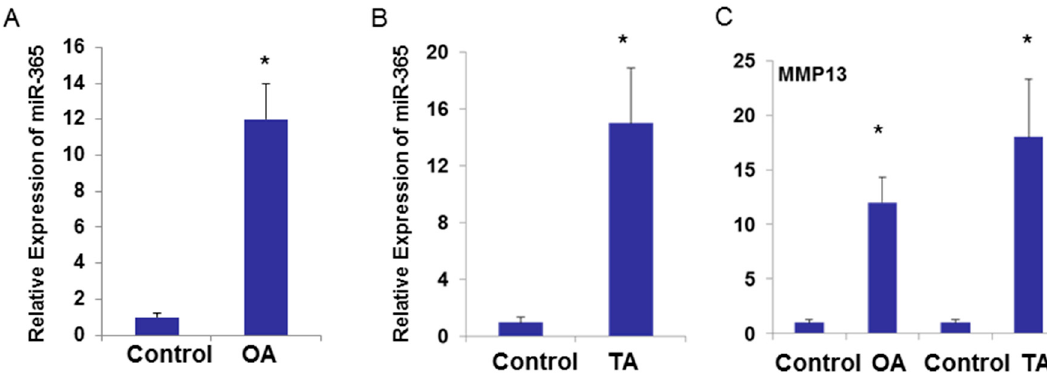
Figure 4. miR-365 is up-regulated in human OA cartilage. ( A – C ) RNA was collected with human primary or traumatic OA cartilage in loading area or normal looking cartilage from non-load control cartilage ( n = 15) and were analyzed by TaqMan miRNA assay for miR-365 expression ( B , C ) and by SYBR Green real-time polymerase chain reaction for MMP13 mRNA expression. OA, cartilages are from primary OA patients; TA, cartilage are from traumatic OA. * p < 0.05.